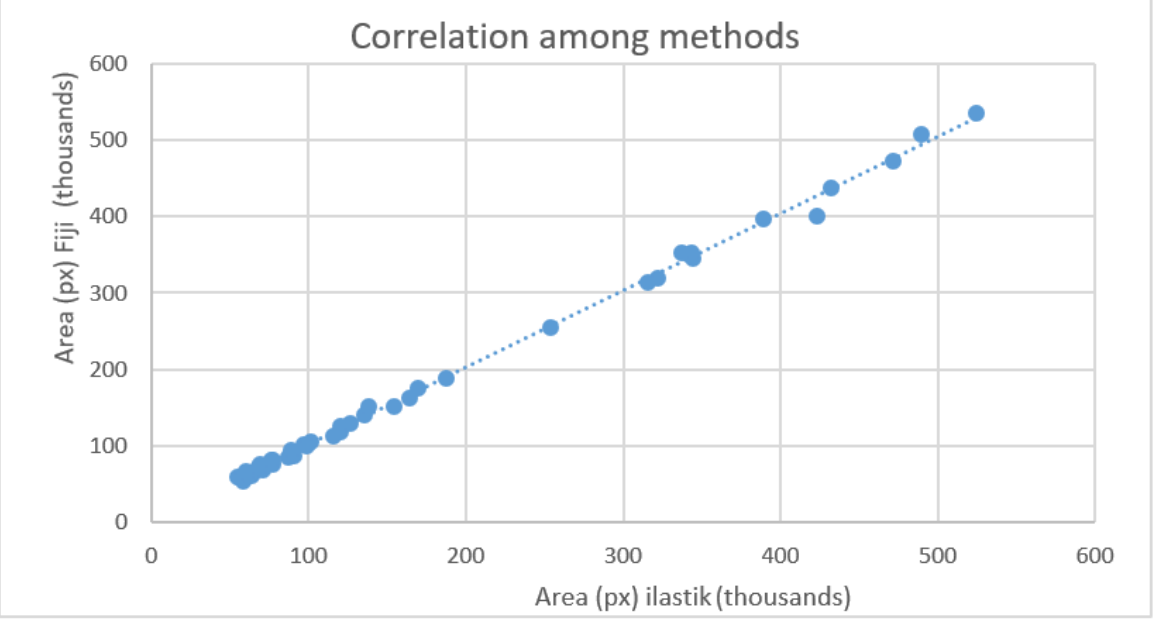
Figure 2. Graph shows plotted output data (pixel) of the same images analysed with the two methods (Fiji and ilastik ® ). As demonstrated by the data visualisation, a strong correlation between the two methods is present.